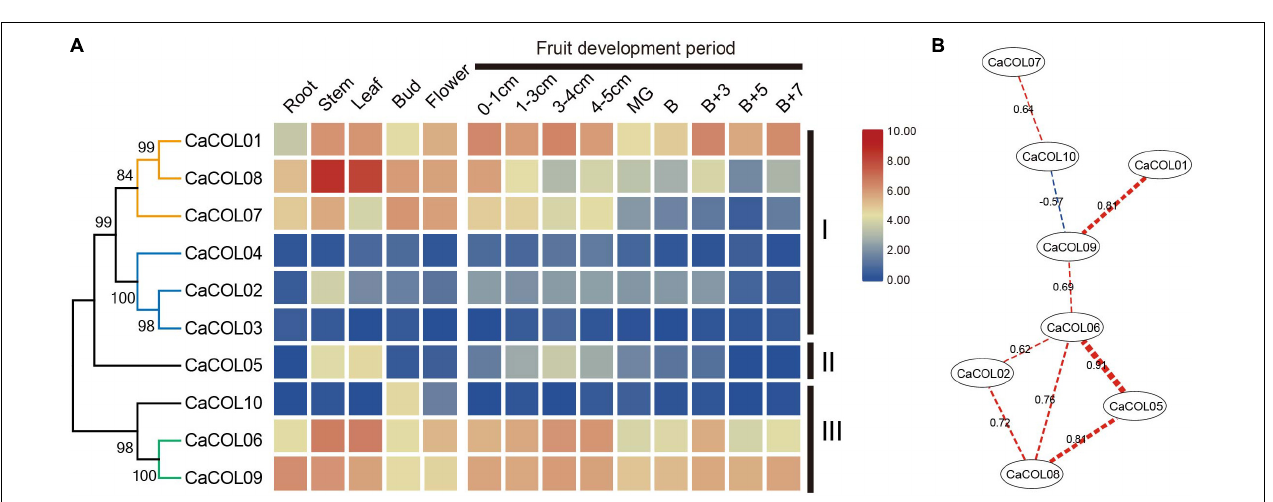
FIGURE 6 | Copy number variation of the COL family in 12 selected plant species. The phylogenetic tree of AtCOLs is shown on the left, and the species tree is shown at the top. Whole-genome duplication and triplication events are indicated on the tree branches according to the Plant Genome Duplication Database. Numbers are copy numbers of each gene in Arabidopsis thaliana (Ath), Brassica rapa (Bra), Carica papaya (Cpa), Populus trichocarpa (Ptr), Fragaria vesca (Fve), Vitis vinifera (Vvi), Solanum tuberosum (Stu), Solanum lycopersicum (Sly), Capsicum annuum (Can), Zea mays (Zma), Oryza sativa (Osa), and Amborella trichopoda (Atr). Statistics of copy number variation of the COL genes are based on the phylogenetic relationships.